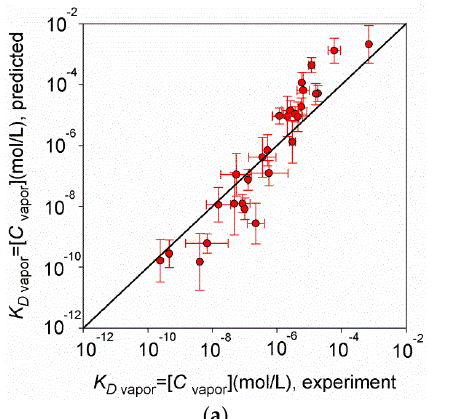
7 of 10 blue dashed line in ( b ) is the best-fit line. The green horizontal dashed line denotes the mean value, 𝛿𝑥̅̅̅ = 0.84 Å . However, the 𝛿𝑥 value, actually, has to be dependent on the strength of the binding of the molecule in the crystal, and the stronger the binding, the smaller the range of al- lowed movements should be. Accounting for the dependence of 𝛿𝑥 on the strength of binding (see the blue dashed line in Figure 2b) could, in principle, improve our estimate of the entropies and crystal-to-vapor dissociation constants. However, our attempts to ob- tain such an improvement led to such negligible results that we returned to the equal 𝛿𝑥̅̅̅ values for all molecules. 3.2. Vapor-Solution Equilibrium and Calculation of Dissociation Constants For the second transition (vapor-to-solution), we only use the experimental Henry constant k H,cc (see Ref. [29] and Equation (6)). Henry constants for each of the investigated 28 compounds were collected [16] from the literature and listed in Supplementary Table